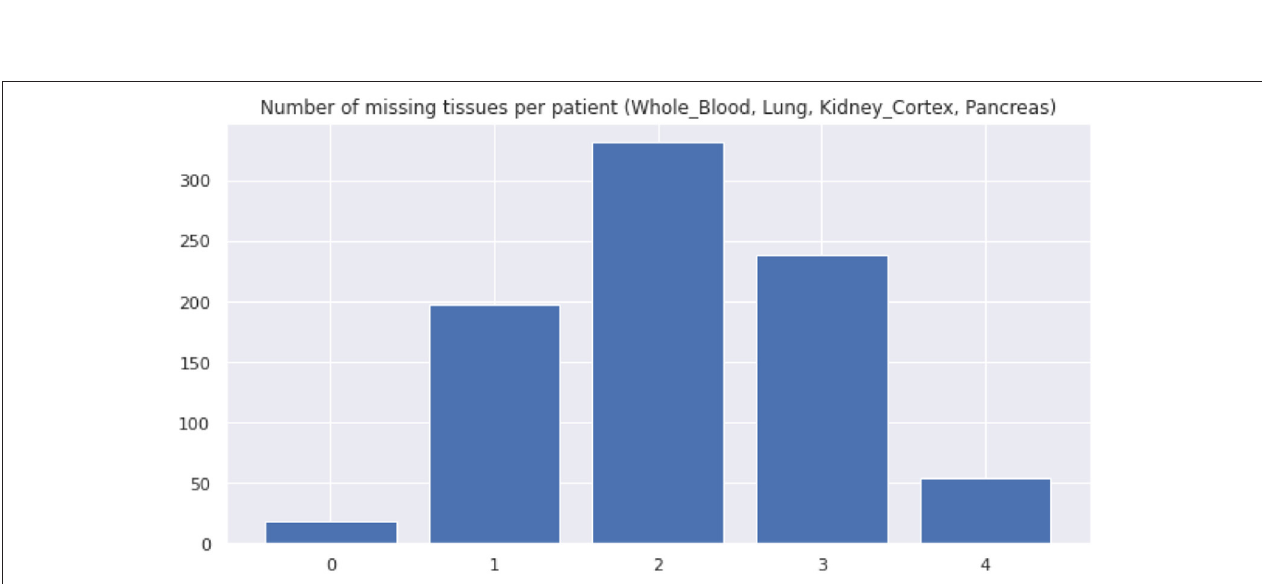
FIGURE 8 | Distribution of missing tissues per GTEx patient. This plot only considers 4 tissue types (whole blood, lung, kidney (cortex), and pancreas).